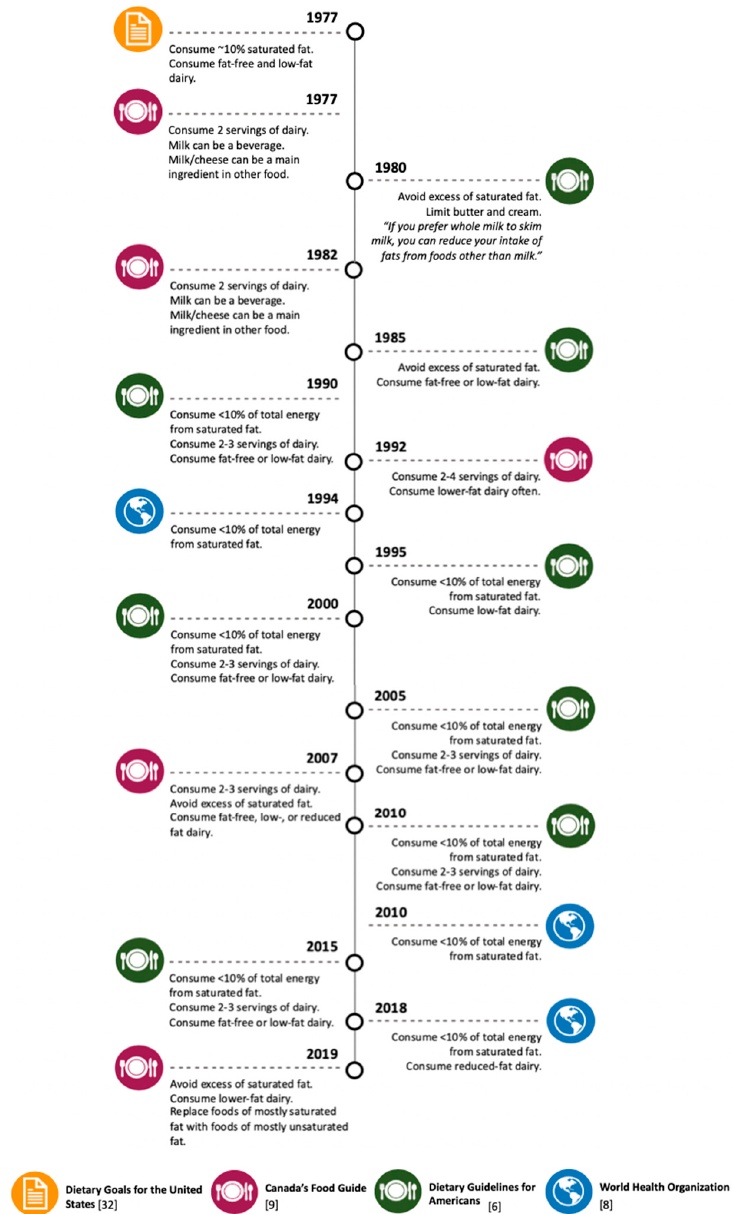
Figure 1. Timeline of the evolvement of dietary recommendations of total, saturated, and dairy- derived fat intake for the United States, Canada, and world health organization.